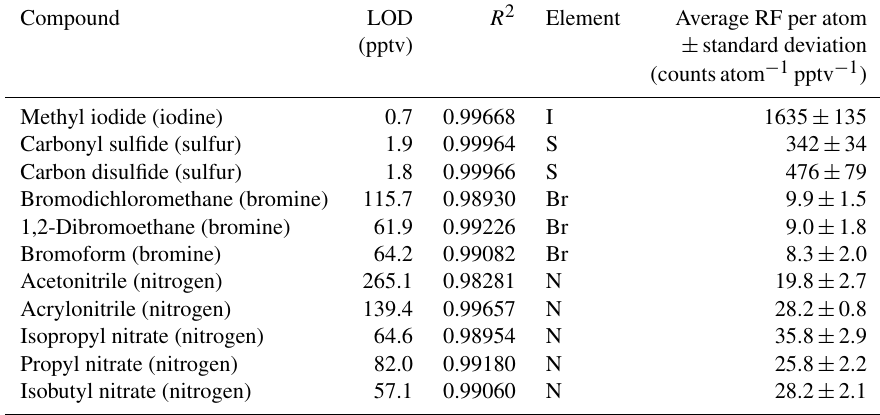
Table 2. CryoTrap–GC–AED system limits of detection (LODs) at the 3 σ level, R 2 linearity, and response factors (RFs) per iodine, sulfur, bromine, and nitrogen atom value derived from Apel-Riemer-2015 calibration standard measurements ± standard deviation at the 1 σ